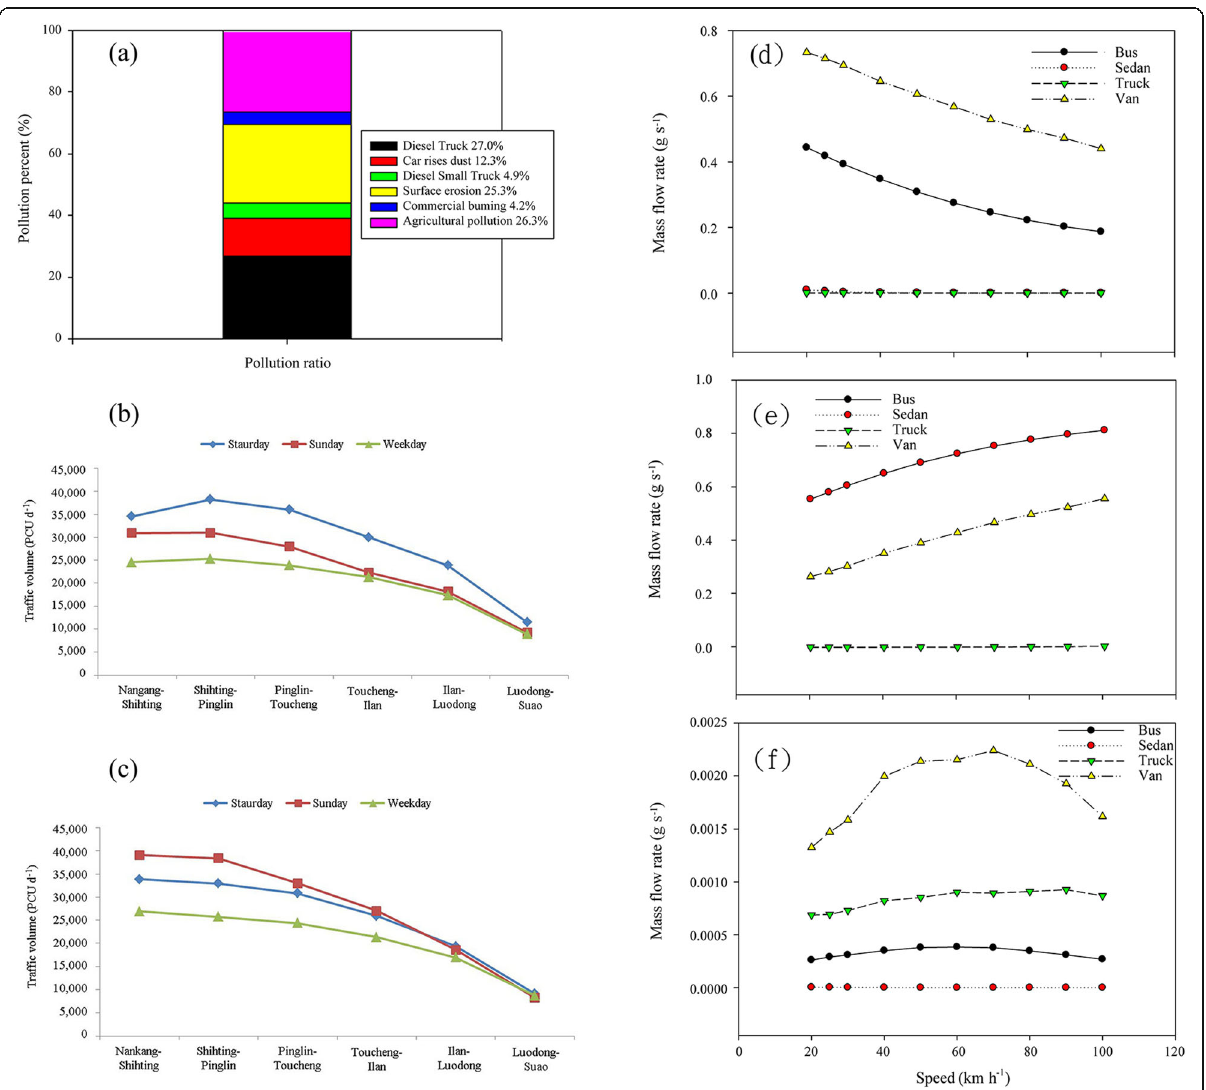
Fig. 4 a Pollutant concentration ratio of Toucheng; b traffic volume of highway No. 5 in the south direction; c traffic volume of highway No. 5 in the north direction; d CO exhaust emissions at different speeds; e NO exhaust emissions; f SO 2 exhaust emissions